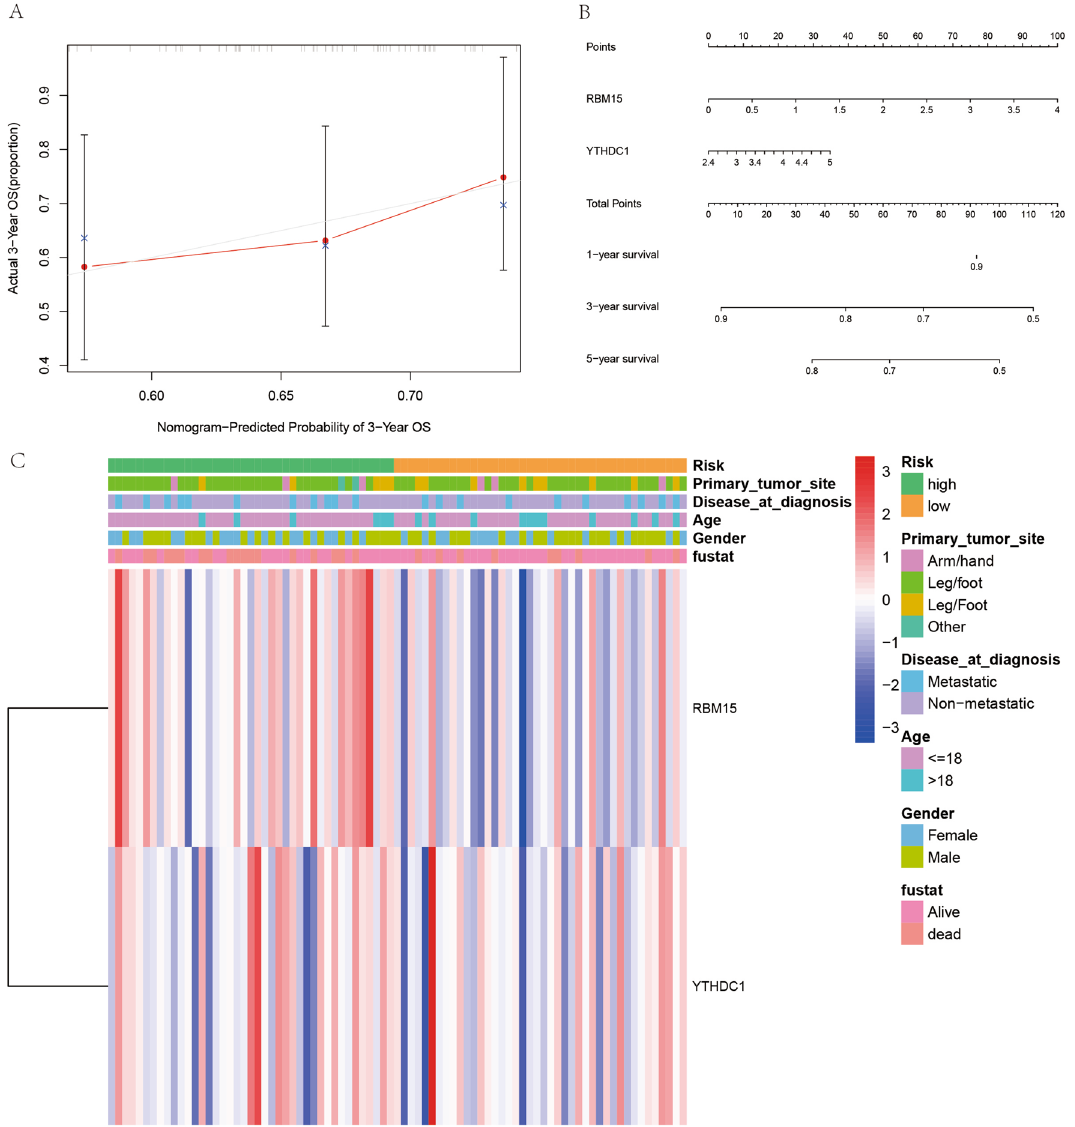
Figure 8. M6A-related osteosarcoma prognostic model validation and clinical correlation analysis. ( A ) Represents the calibration curve plot, the predicted starting point and the predicted end point basically overlap. ( B ) Represents the column line plot, which can be used to predict the prognosis of osteosarcoma patients. ( C ) Is the clinical correlation analysis